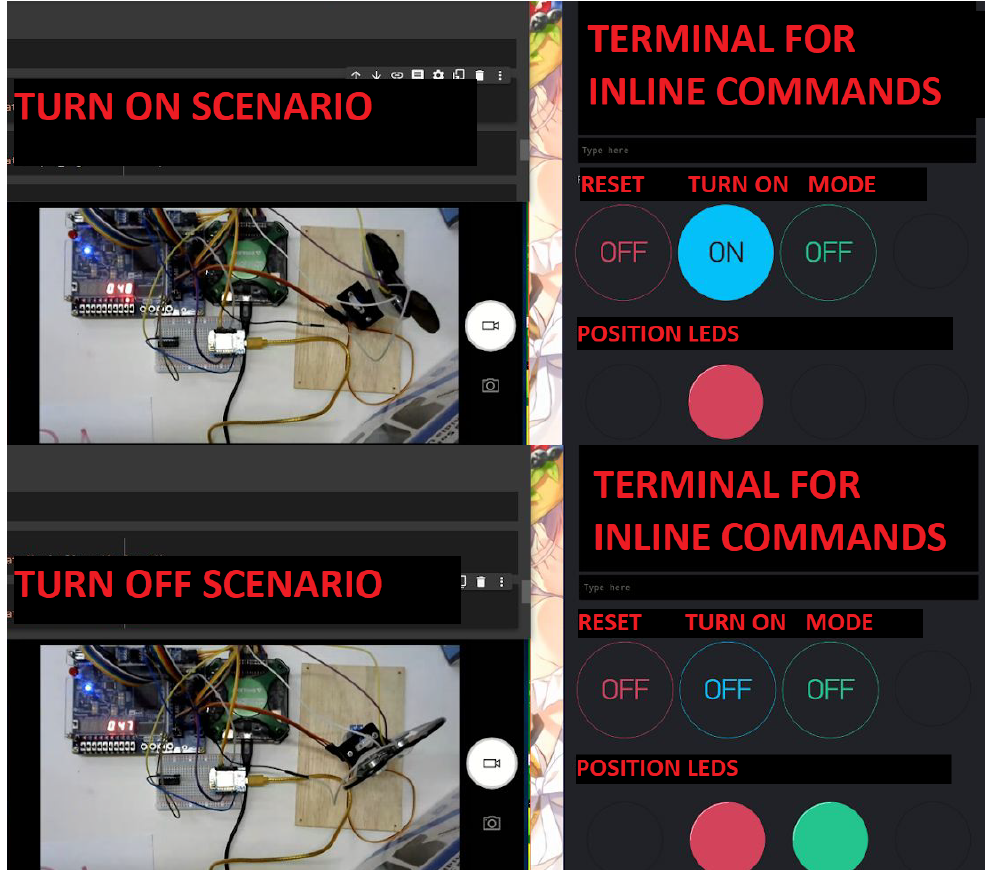
Figure 10. Parking Sensor